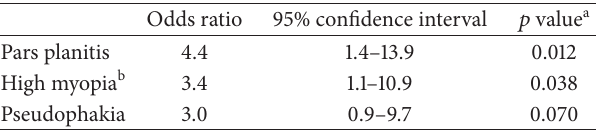
Table 3: Preoperative clinical factors associated with primary anatomical failure after rhegmatogenous retinal detachment surgery with scleral